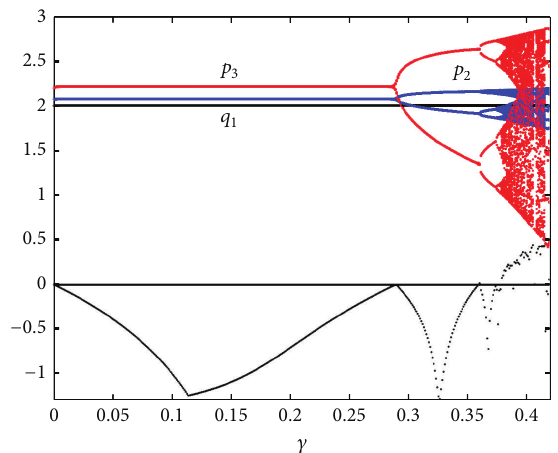
Figure 4: Bifurcation diagram and the Largest Lyapunov exponent of the discrete dynamic system (7) for 𝛼 = 0.5 , 𝛽 = 0.15 , and 𝛾 varying from 0 to 0.44.